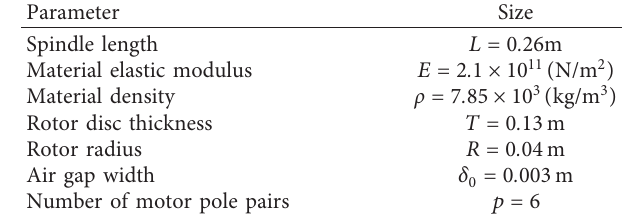
Table 1: Structural parameters of motorized spindle.